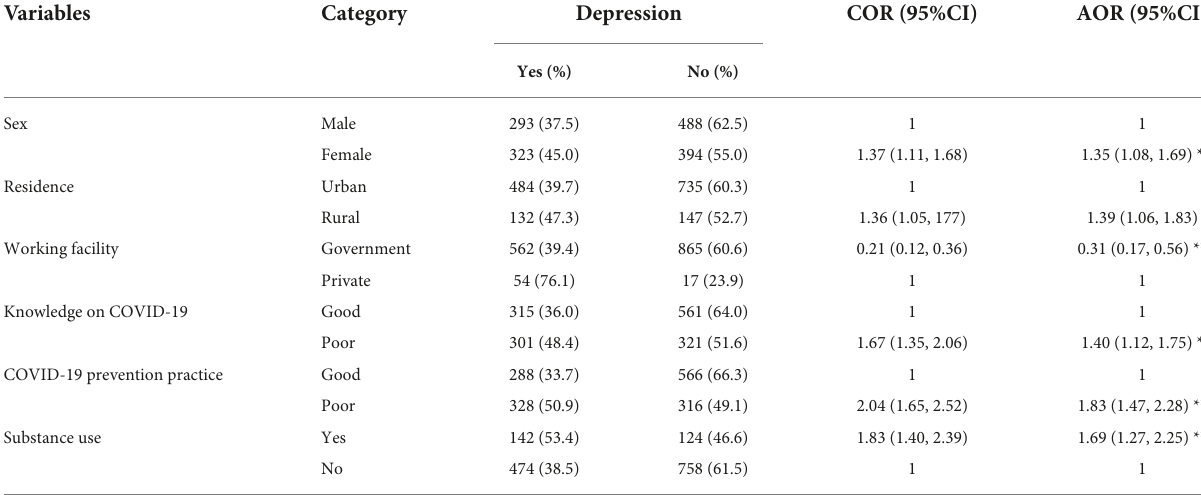
TABLE 2 Bivariable and multivariable logistic regression analysis for factors associated with depression among midwives in Ethiopia in 2020 ( n =